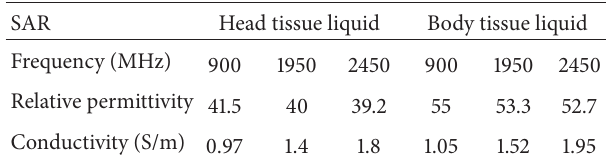
Table 2: SAR tissue data.